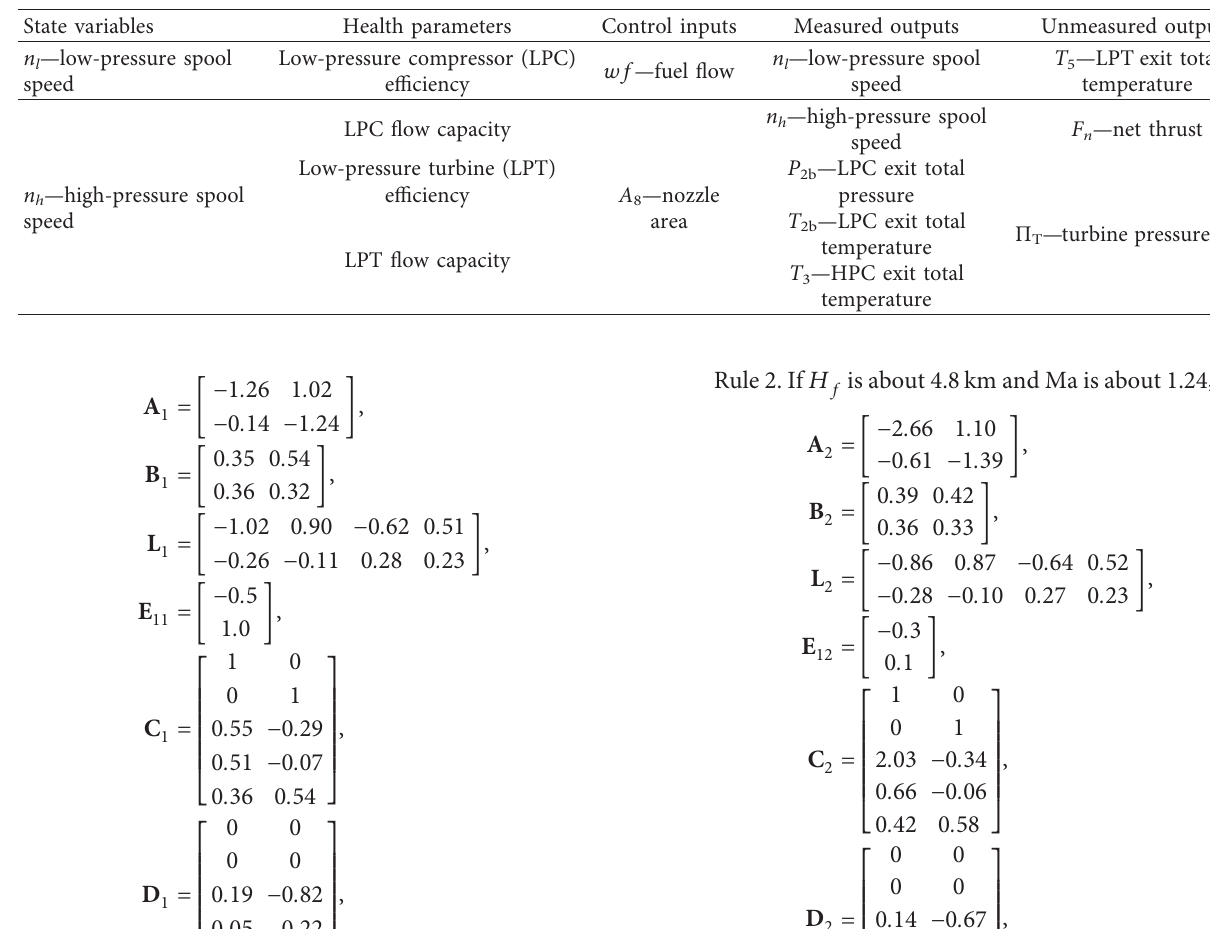
Table 1: Variables of aeroengine T-S fuzzy